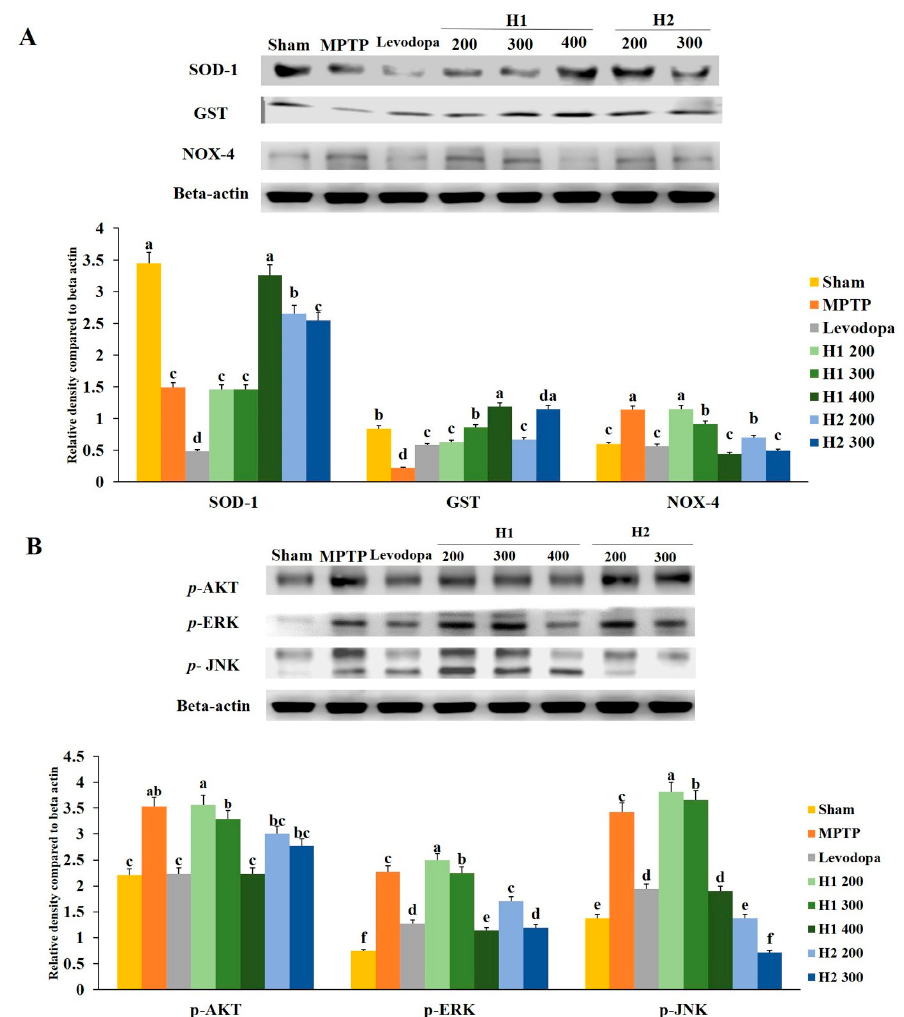
Figure 6. ( A ) Effects of Hepad 1 (H1) and Hepad 2 (H2) (S5) on the expression of anti-oxidant-related proteins in the brains of the Parkinson’s disease mouse model. Superoxide dismutase (SOD), glutathione S-transferase (GST), and nicotinamide adenine dinucleotide phosphate oxidase 4 (NOX-4) levels were assessed by Western blotting. ( B ) Effects of H1 and H2 (S5) on the expression of phosphorylated protein kinase B ( p -AKT), phosphorylated extracellular signal-regulated kinase ( p -ERK), and phosphorylated c-Jun N-terminal kinase ( p -JNK) in the brains of the Parkinson’s disease mouse model. Results are expressed as the mean ± the standard deviation. Level of statistical significance